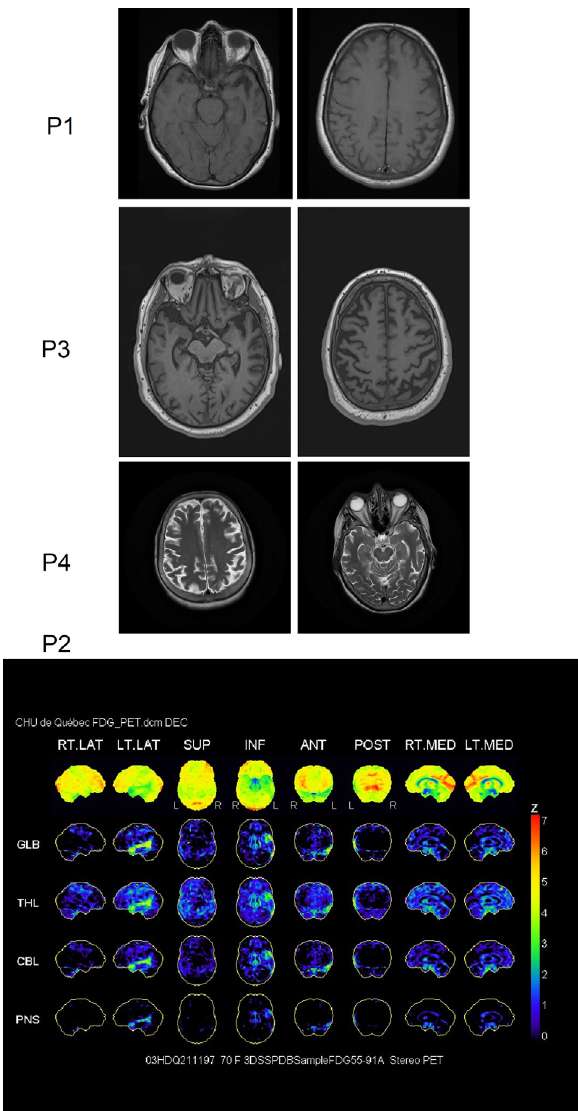
Figure 1. Transverse weighted MR images for P1, P3 and P4 and FDG-PET scans of P2. P1. Axial 3DT1 MRI showing left anterior temporal and left hippocampal (left image) and left parietal atrophy (right image). P3. Axial 3DT1 MRI showing left temporal (left image) and left posterior parietal atrophy (right image). P4. Axial T2 MRI showing left parietal (left image) and left temporal atrophy (right image). P2. 18F-FDG-PET showing left temporoparietal